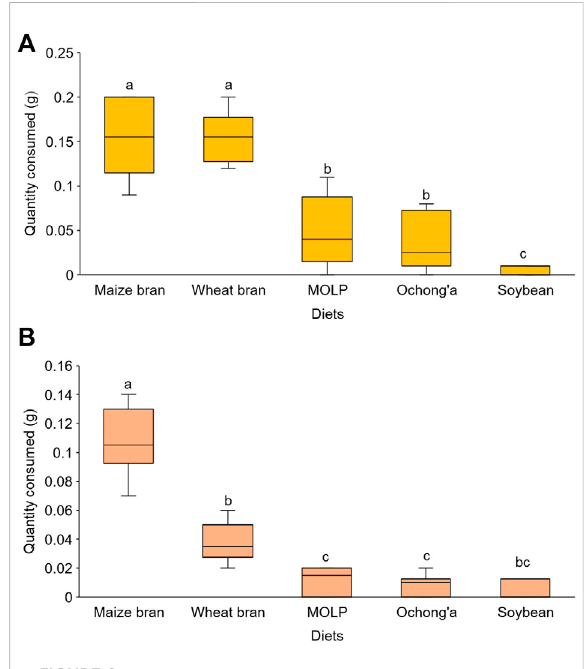
FIGURE 2 (A) Acceptanceand (B) preference of differentdiet substrates by Ruspolia differens ranging from the most to the least preferred. Box plots capped with different letters differed signi fi cantly at p <